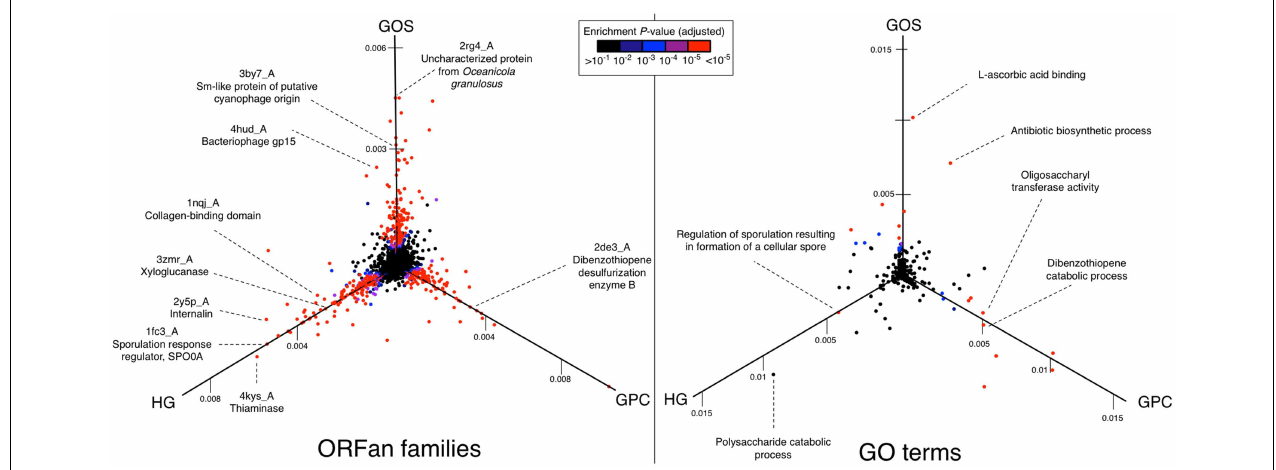
database, and functions are defined by GO terms as described in the Methods. Data points that project uniquely along one axis therefore indicate metagenome-specific ORFan families or functions, while those close to the origin indicate similar proportions among all three metagenomes. Cases described in the text have been